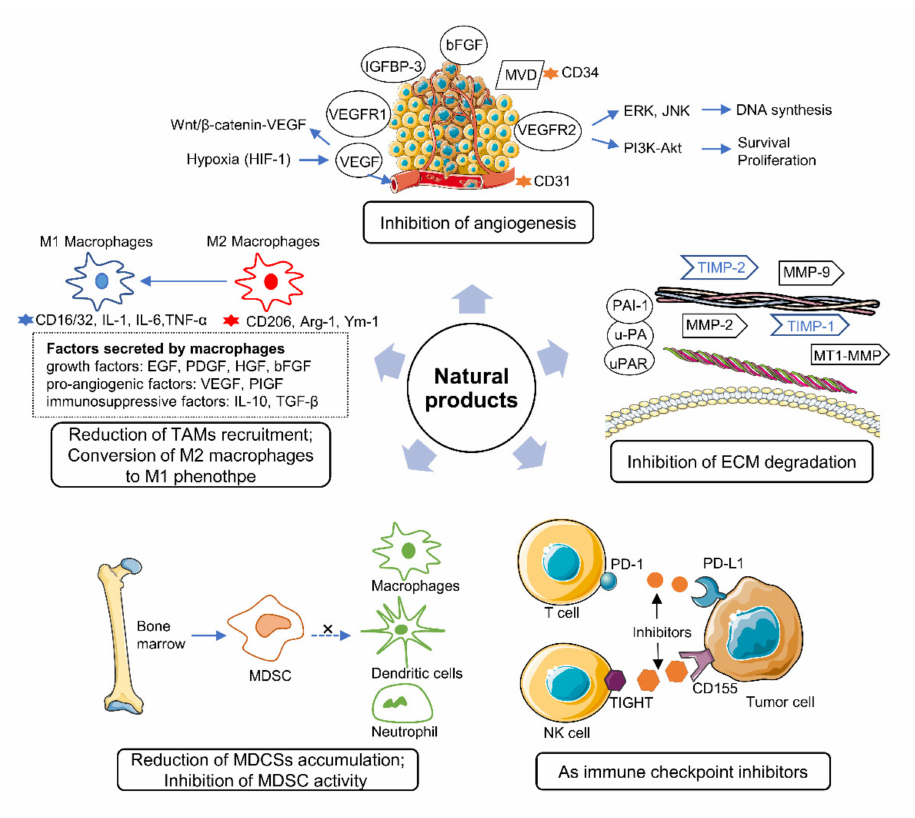
Figure 1. Modulation of the TME by natural